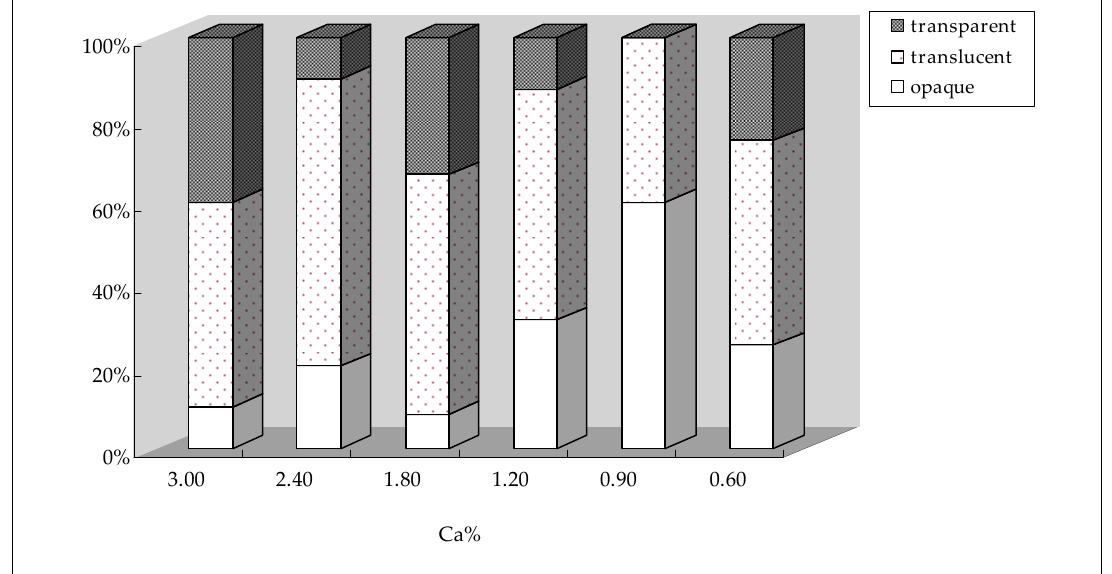
Figure 1. The distribution of transparent, translucent and opaque eggs between different Ca levels at 8 w.